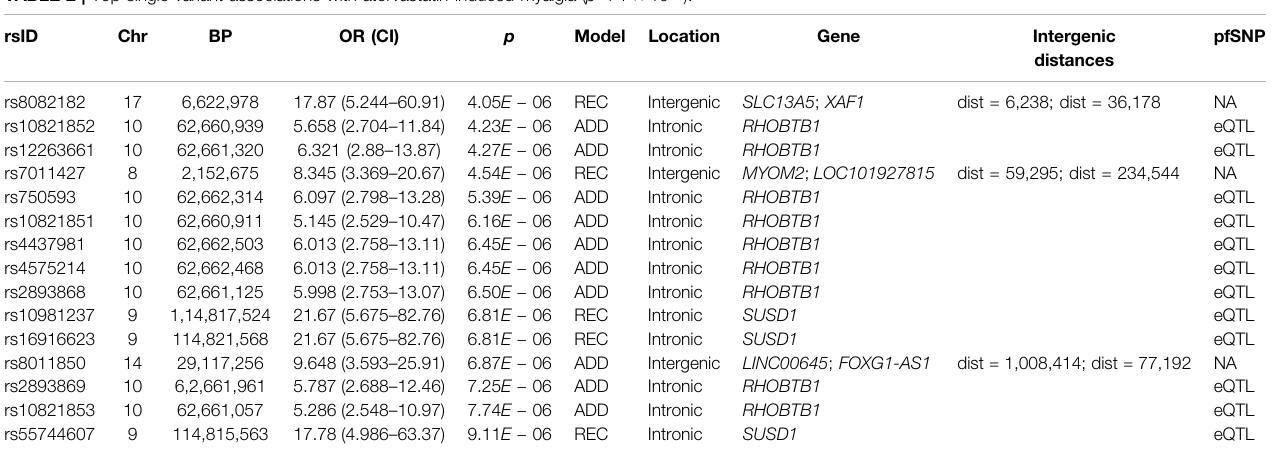
TABLE 2 | Top single variant associations with atorvastatin-induced myalgia ( p < 1 × 10 − 5 ). rsID